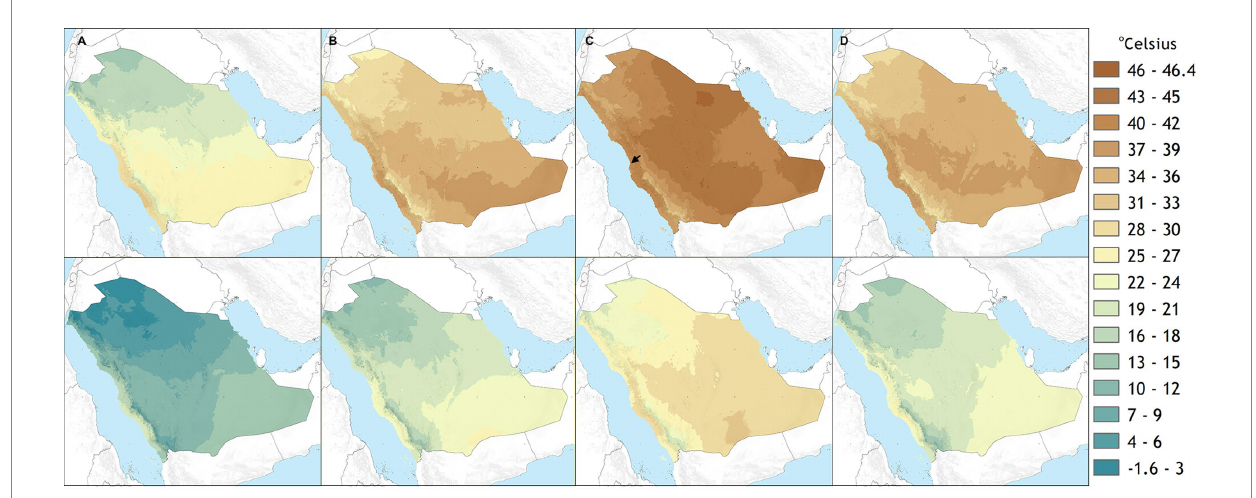
FIGURE 5 Mean maximum (upper) and minimum (lower) average monthly temperature for January (A) , April (B) , August (C) , and October (D) at ground level from 1970–2000 in Saudi Arabia (Fick and Hijmans, 2017). The location of the KAUST DAB-KSA pilot facility site of cultivation is indicated with a black